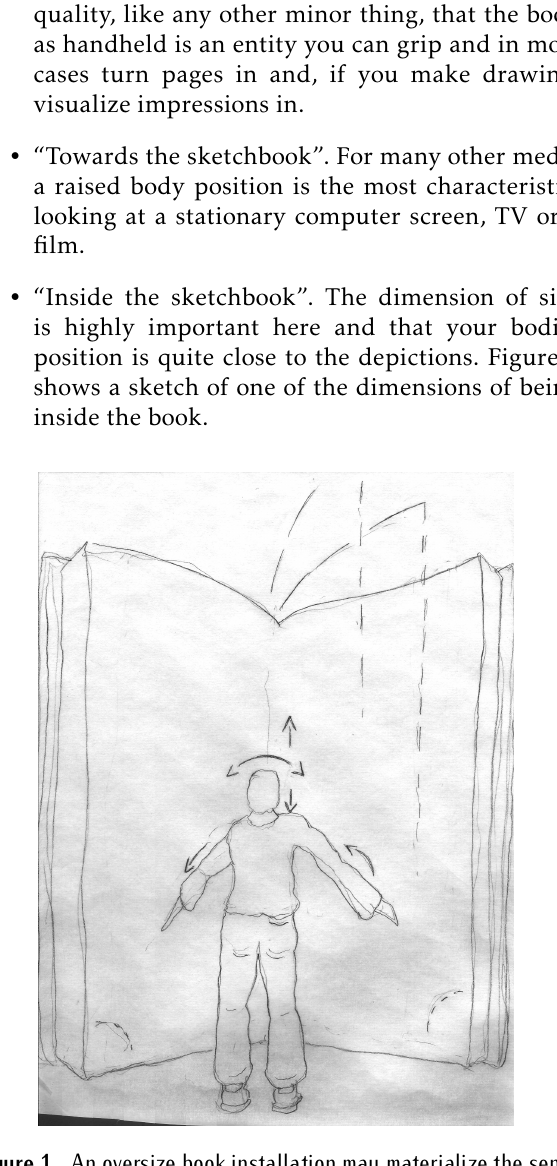
Figure 1. An oversize book installation may materialize the sense of being inside the book, transforming Hans Christian Andersen’s imaginations into spatial perceptions. The biggest version of our Viskbook installation is H=4.2m, W=2x3.2m. (Drawing: